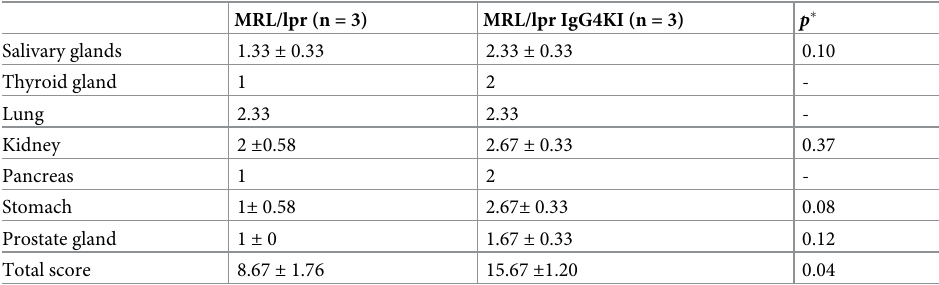
Table 3. Scoring of hematoxylin and eosin (H&E)-stained tissue sections.